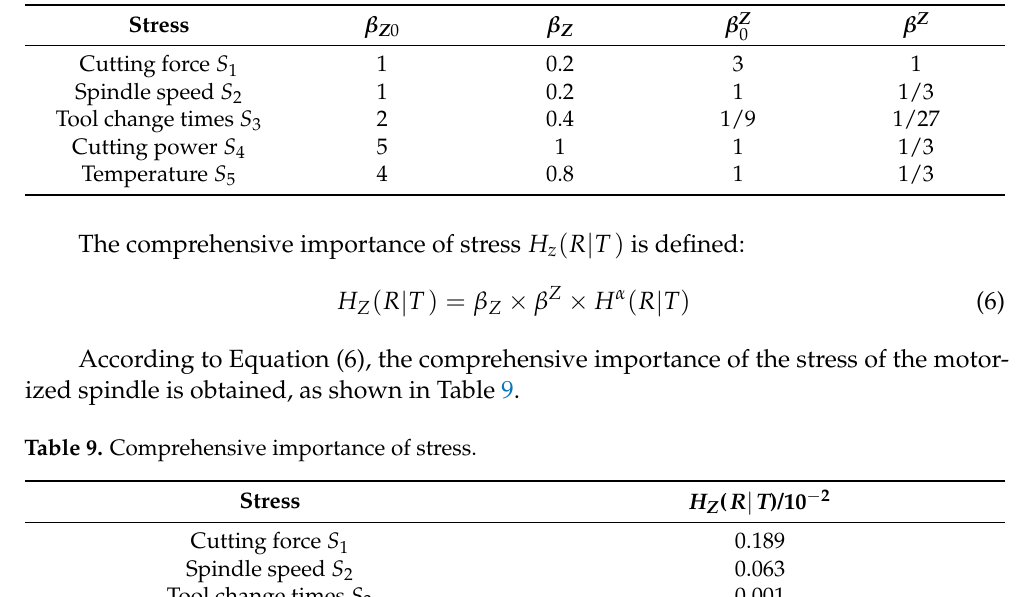
Table 8. The influence range coefficient β Z and action coefficient β Z .